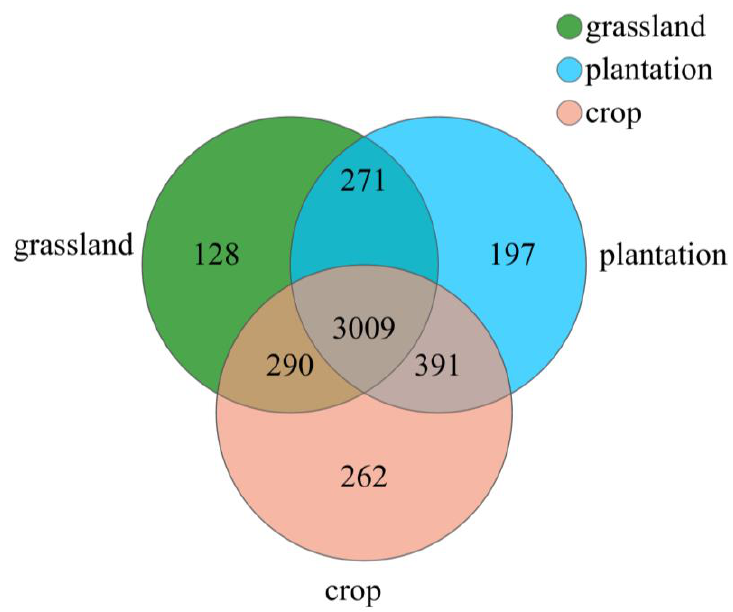
Figure 3. OTU Venn map of soil bacteria in three karst land-use types.